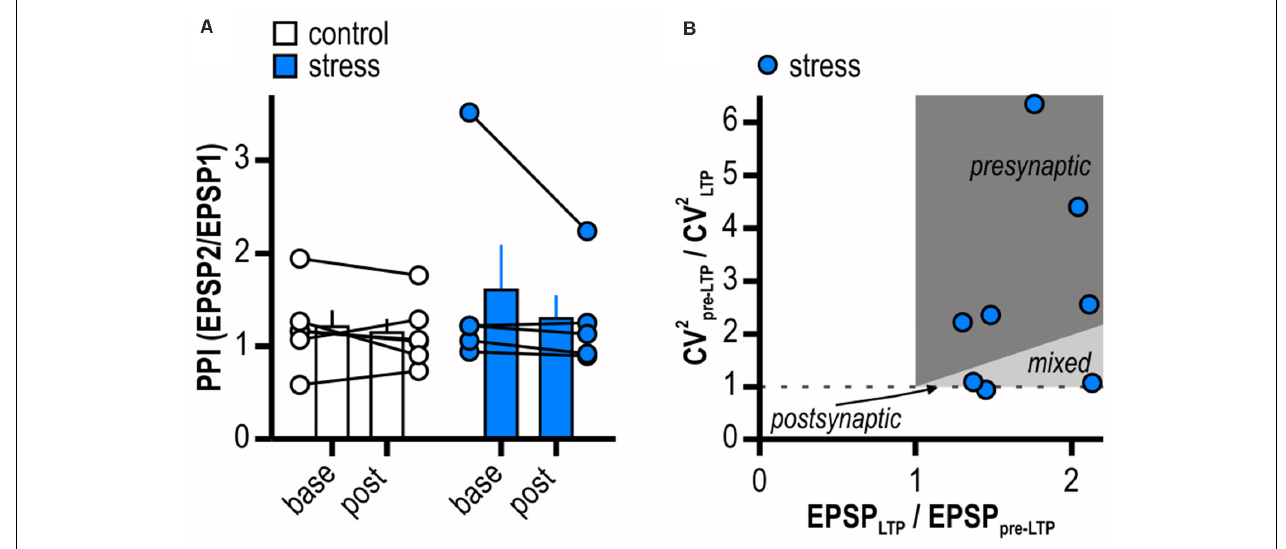
FIGURE 3 | LTP in stressed rats is expressed pre- and postsynaptically. (A) Quantification of paired-pulse index (PPI). Circles depict the mean value of single neurons before ( base ) and after ( post ) LTP induction, columns represent mean ± SEM of all recorded neurons. Paired-pulse index (PPI) does not change after induction of LTP in stressed rats (control: n = 6/5, paired Student’s t -test, p = 0.50; stress: n = 5/5, paired Student’s t -test, p = 0.28). (B) Plot relating the ratio of the coefficients of variation (CV) squared to the ratio of the mean EPSP amplitudes in stressed rats. Classically, for a single cell the locus for potentiation is postsynaptic when data is on horizontal line, presynaptic when above the identity line or both when between the horizontal and the identity line.